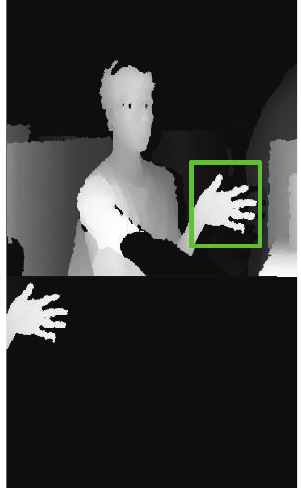
Figure 9: The image at the bottom shows the palm area